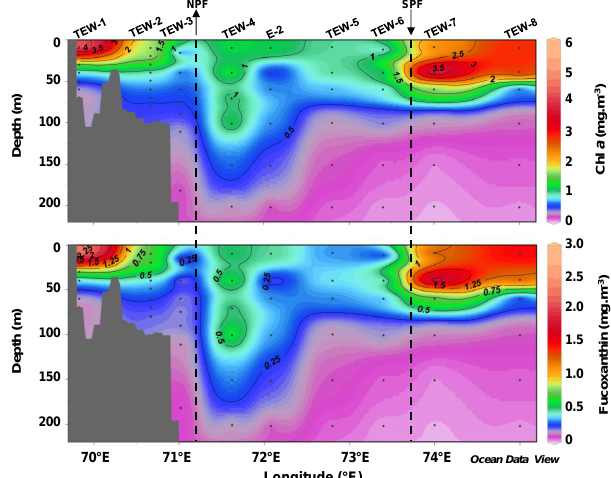
Figure 3. Figure 3. Vertical distribution of total chlorophyll a (chl a ) and fucoxanthin concentrations along the TNS transect. The dashed line represents the approximate location of the southern branch of the polar front (PF).